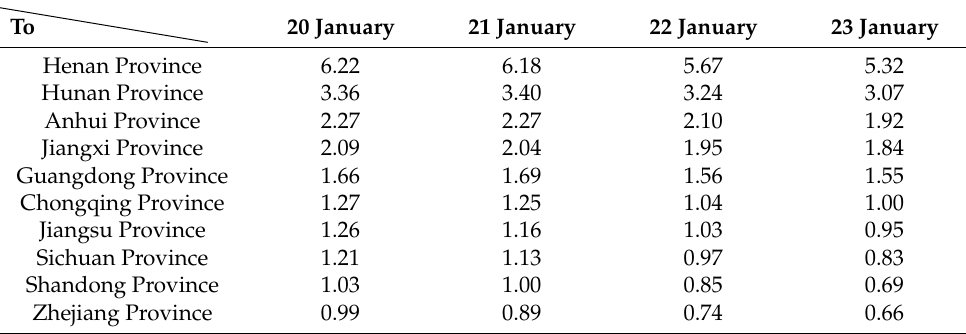
Table 1. Population migration from Wuhan before the lockdown (unit: %).